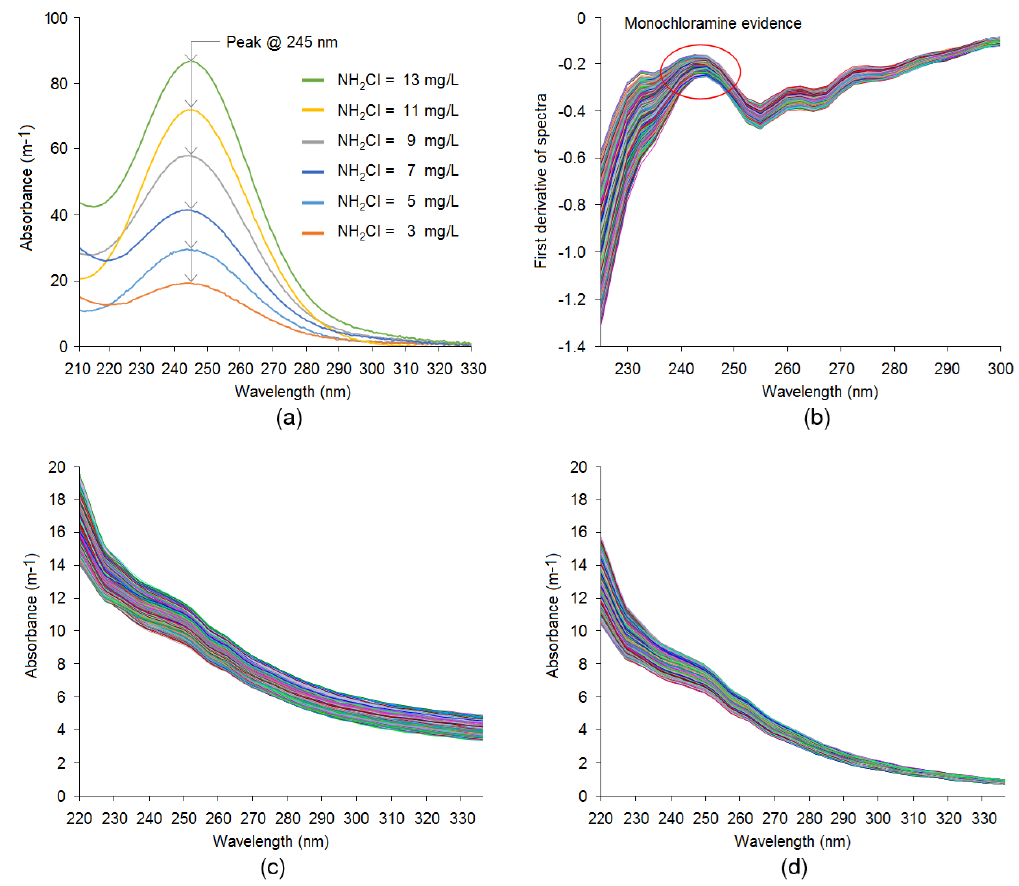
Figure 8. ( a ) Monochloramine spectra in Milli-Q water with different levels of concentration. ( b ) First derivative of spectra. ( c ) Uncompensated spectra, and ( d ) particle compensated spectra.